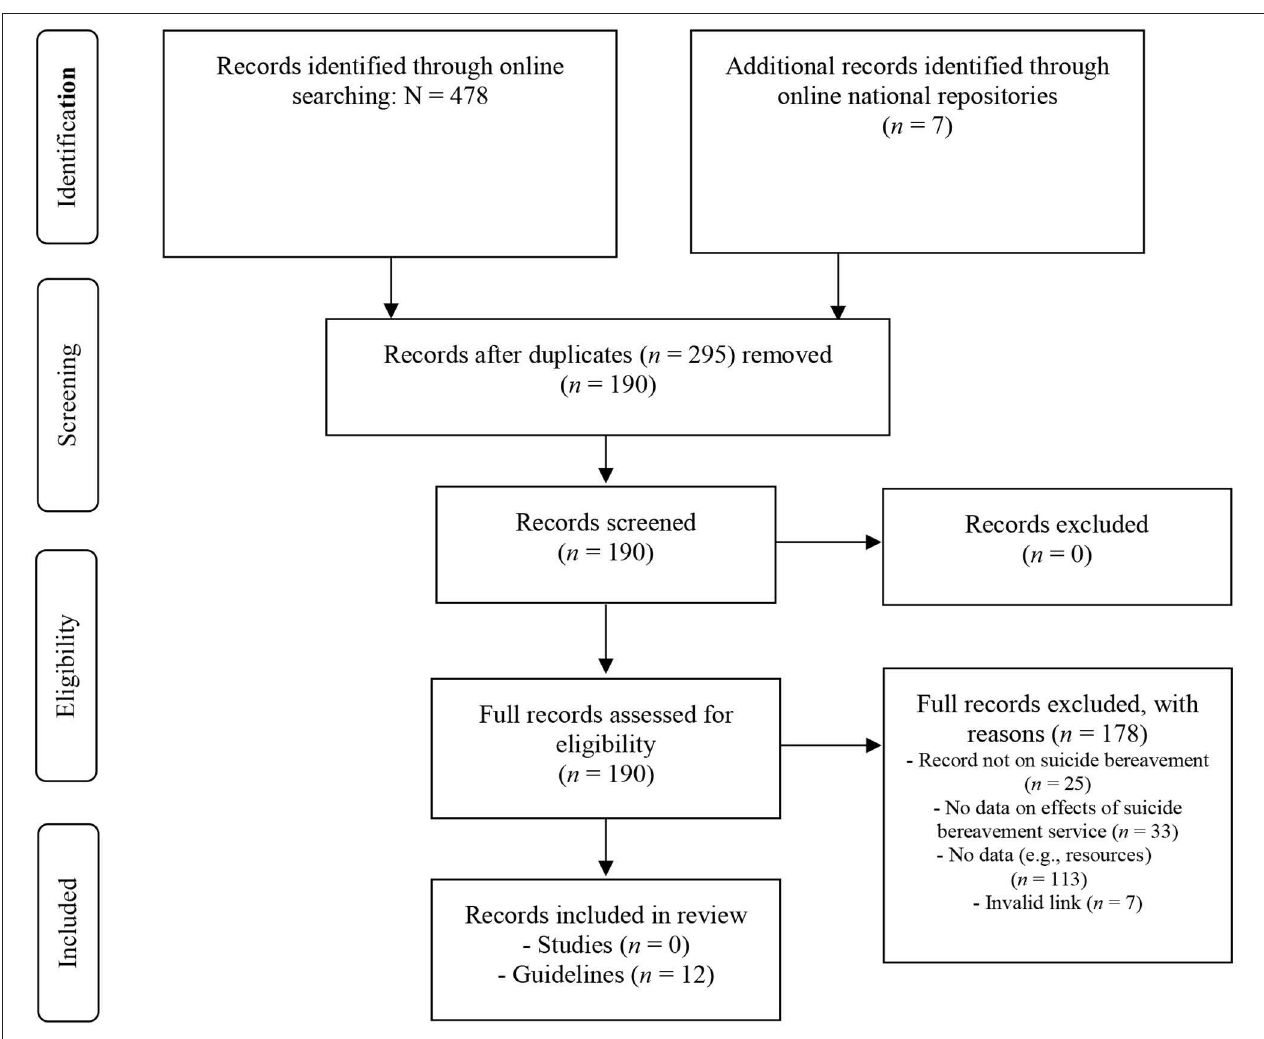
FIGURE 2 | PRISMA flow diagram: gray